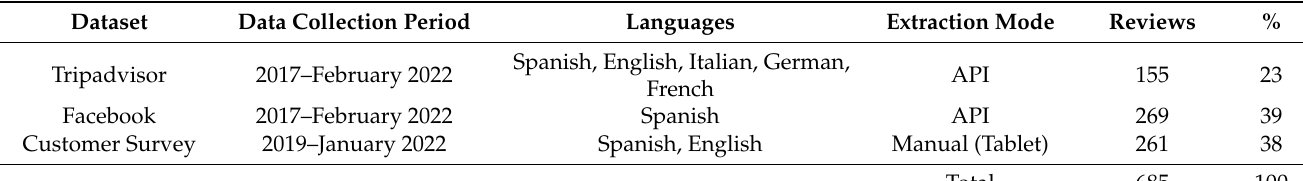
Table 1. Case study databases.